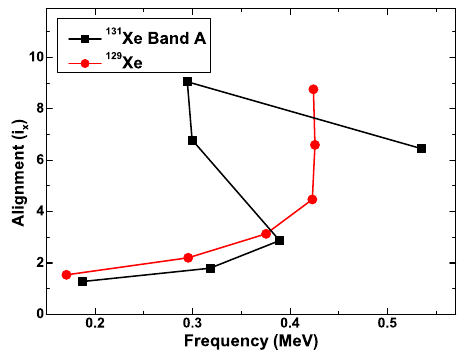
Figure 4. Alignment ( i x ) vs Frequency plot of the ν h 11 / 2 band in 131 Xe and 129 Xe.